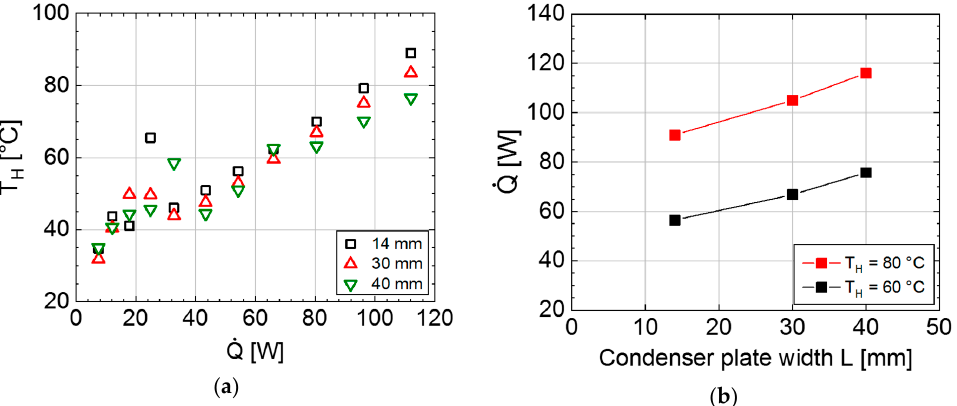
Figure 11. Heat spreading experiments on PHP with 1.5 × 1.5 mm 2 channels in horizontal orientation. ( a ) Plot of heater temperature T H vs. heating power ´ Q for condenser plate widths of 14, 30 and 40 mm; ( b ) “Isothermal” plots of ´ Q vs. condenser plate width L for fixed T H . Data obtained from left plot.